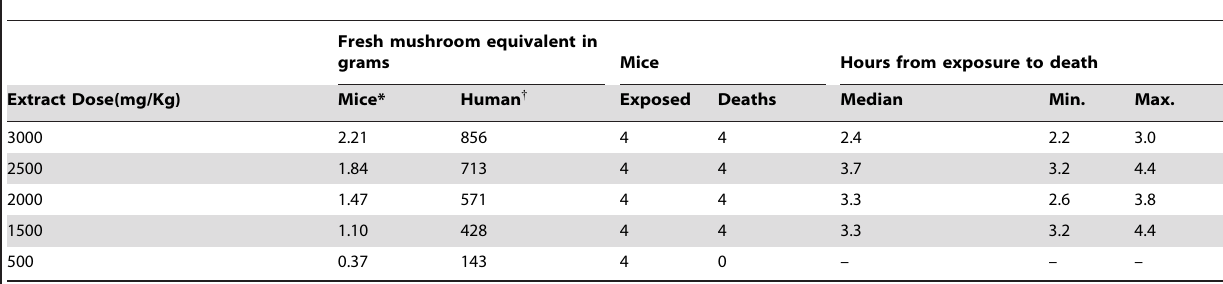
Table 1. Mortality of mice exposed to an extract of Trogia venenata mushrooms by dose of extract.